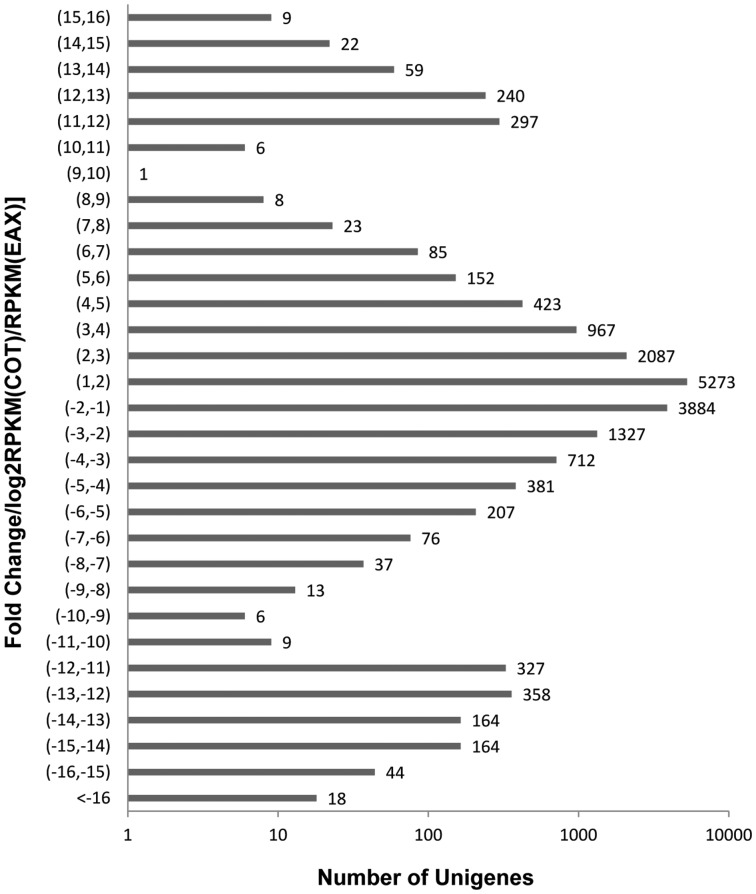
Unigenes that were differentially expressed between cotyledon and embryo axis libraries.Embryo axis abbreviated as EAX, Cotyledon abbreviated as COT, Fold change/EAX/COT (RPKMs) was calculated by the formula: log (RPKM (EAX)/RPKM (COT), 2).